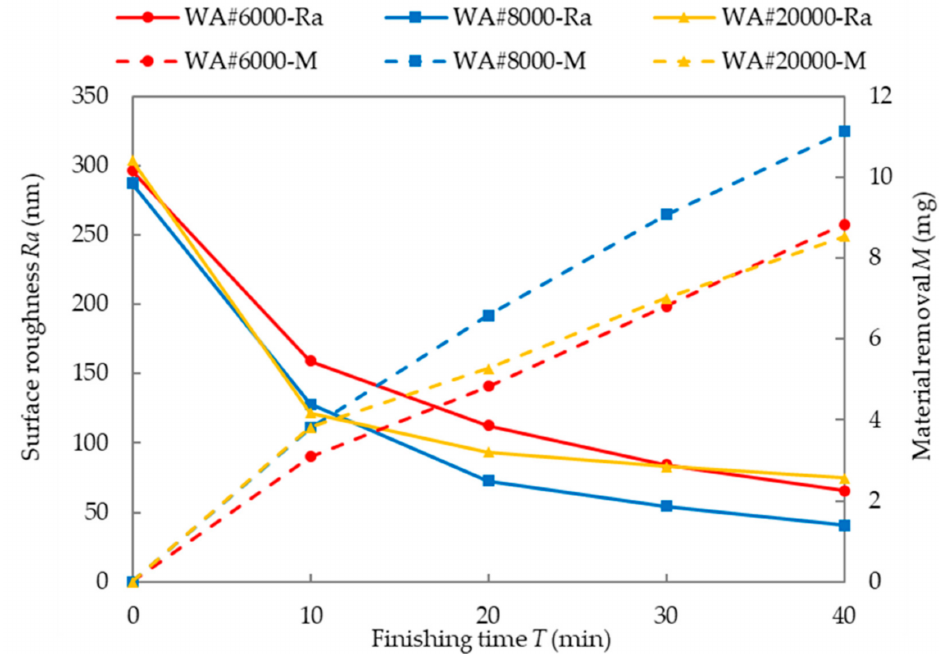
Figure 13. The e ff ect of abrasive particles size on surface roughness and material removal. (Magnetic